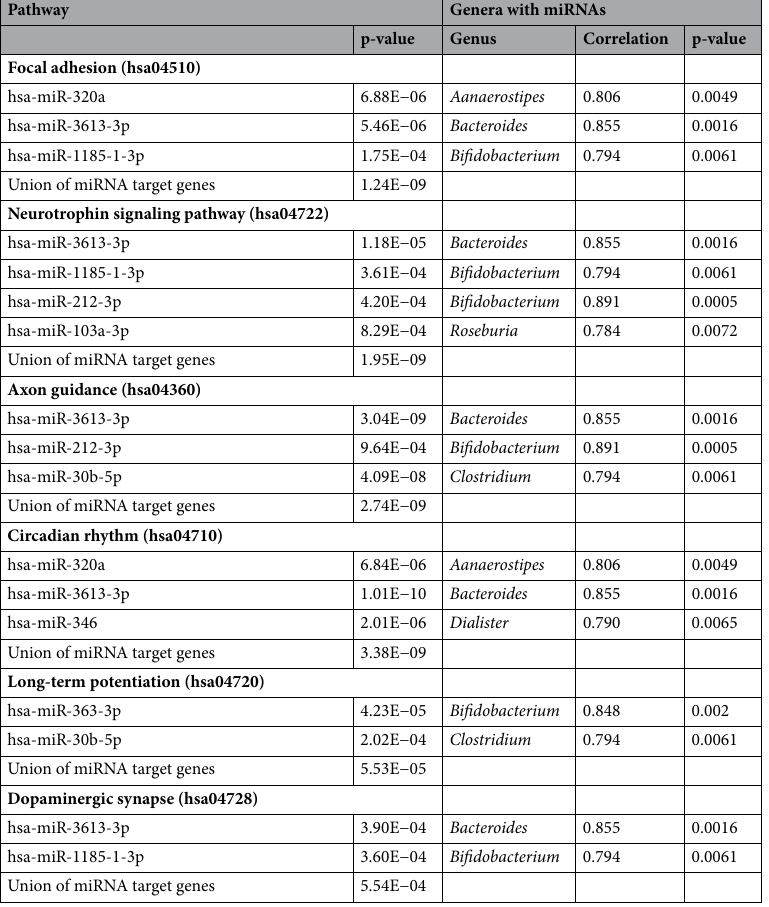
Table 3. Six MDD-associated pathways which were regulated by specific miRNAs of interest. Seven MDD- associated genera shoed significantly positive correlations with these